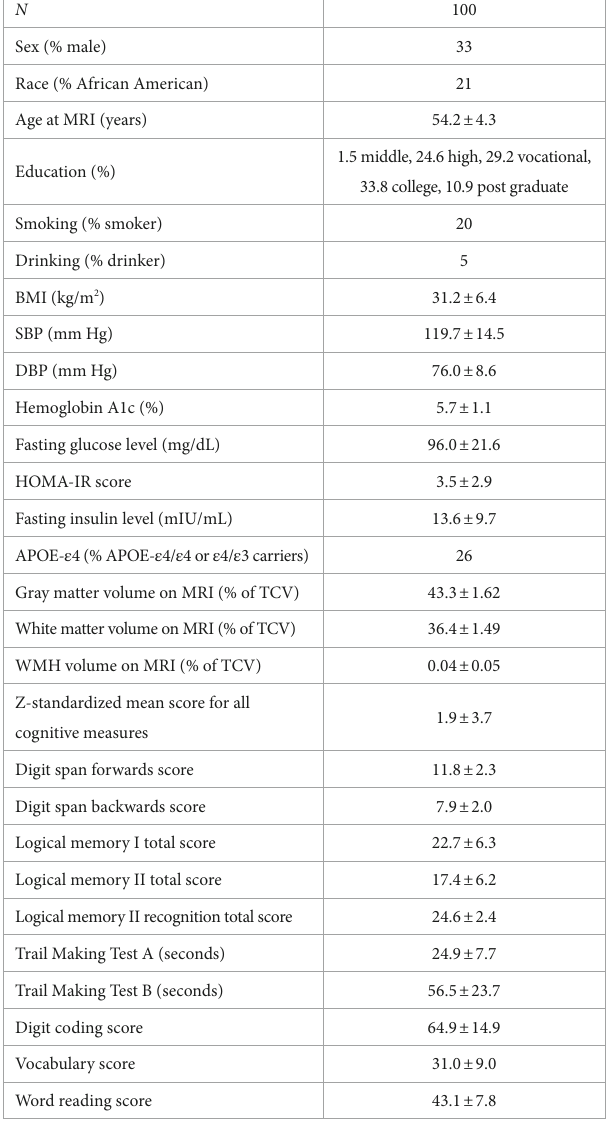
TABLE 1 Participant